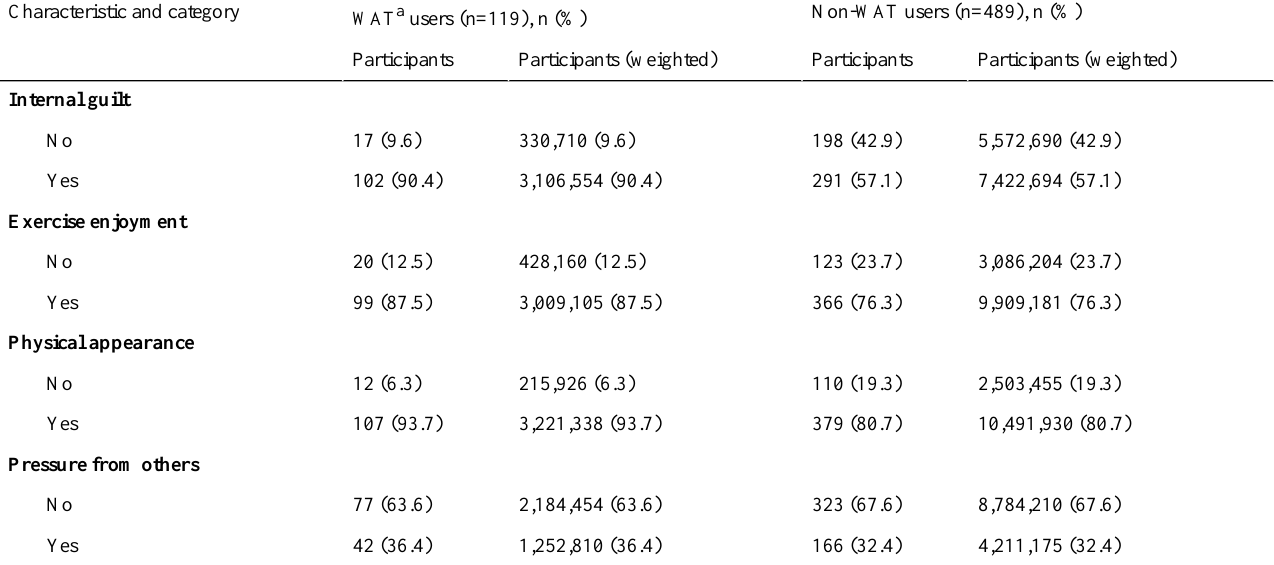
Table 1. Exercise motivations (wearable activity tracker users vs nonwearable activity tracker users; N=608).